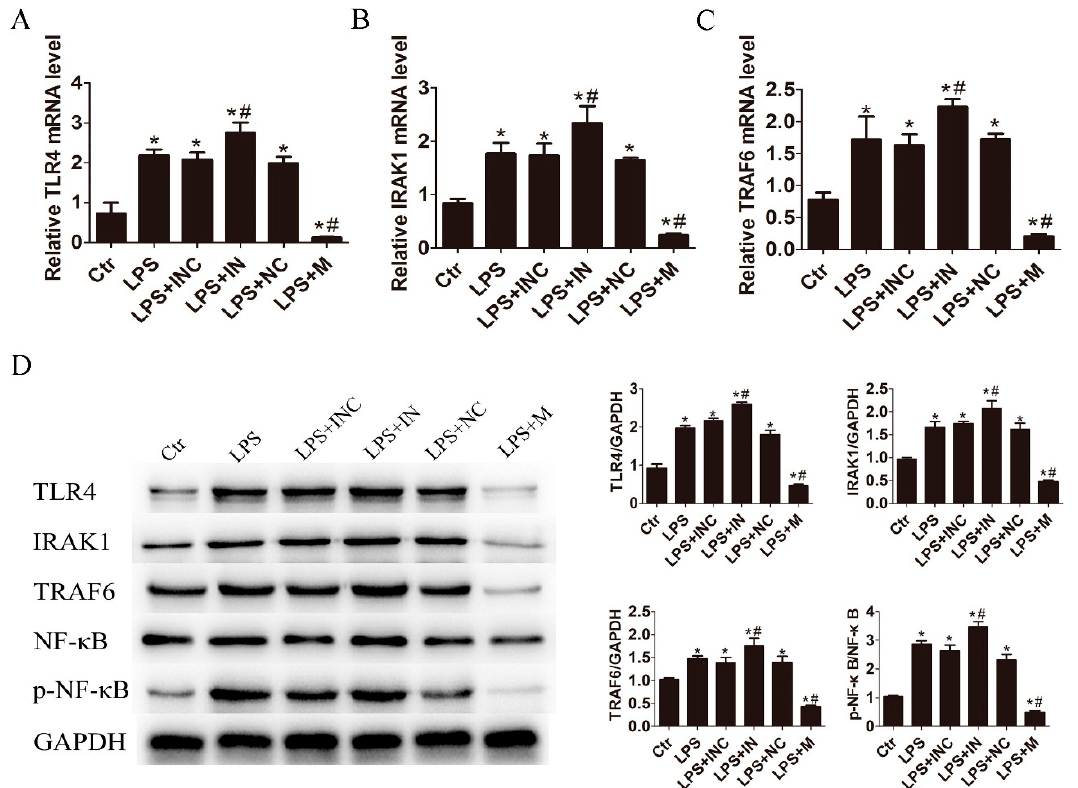
Figure 3. Overexpression of miR-146a-5p inhibited the activation of TLR4/ nuclear factor-kappa B (NF- κ B) pathway. After transfection with miR-146a-5p mimic or miR-146a-5p inhibitor for 24 h, cells were exposed to LPS (500 ng/mL) for 24 h. The mRNA expression levels of: ( A ) TLR4; ( B ) IL-1 receptor-associated kinase 1 (IRAK1); and ( C ) TNF receptor associated factor-6 (TRAF6) were reduced by miR-146a-5p mimic and increased by miR-146a-5p inhibitor in LX2 cells; and ( D ) Western blot showed that miR-146a-5p mimic decreased the expression levels of TLR4, IRAK1 and TRAF6 and phosphorylation of NF- κ B, which was elevated in miR-146a-5p inhibitor treatment group. * p < 0.05 vs. blank control group; # p < 0.05 vs. the corresponding negative control group. Ctr: blank control; INC: miR-146a-5p inhibitor control; IN: miR-146a-5p inhibitor; NC: miR-146a-5p mimic control; M: miR-146a-5p mimic.